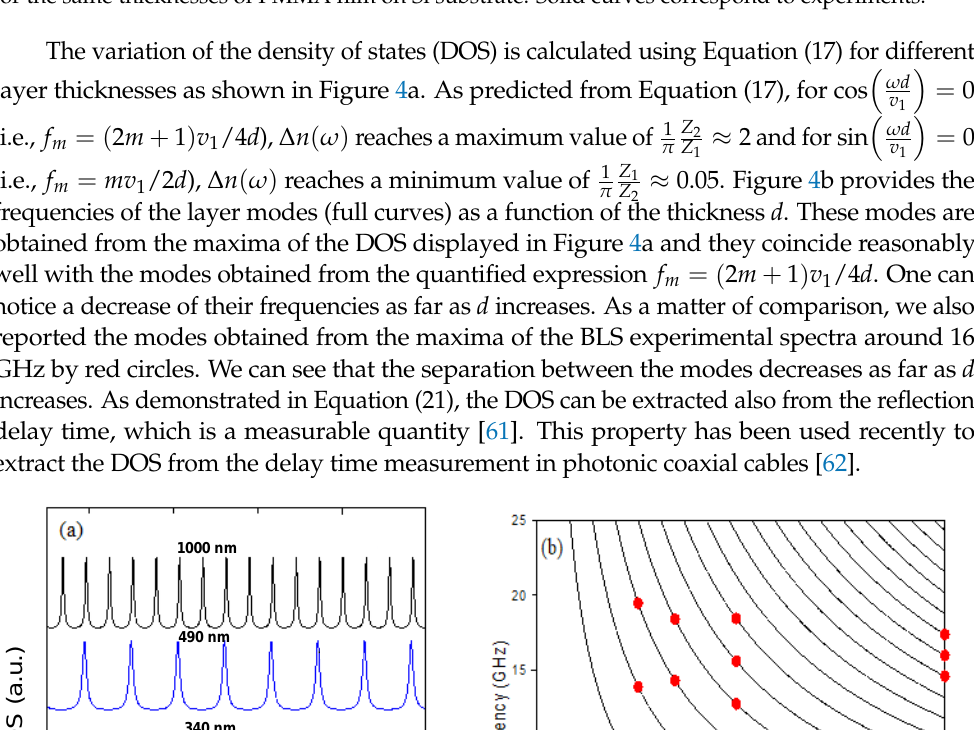
(i.e., f m = mv 1 /2 d ), ∆ n ( ω ) reaches a minimum value of 1